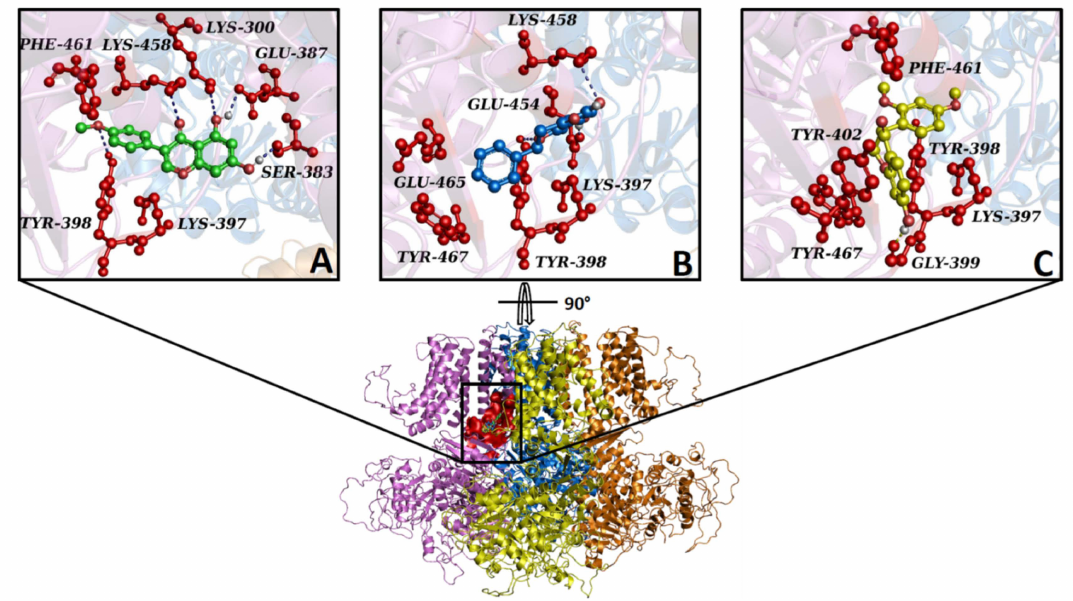
Figure 8. Overview of K Ca 1.1 channels docked with biochanin A, pinocembrin, and sativanone. The K Ca 1.1 channel’s 3D structure is depicted in a multicolour illustration, while the binding pocket is reported as a red surface. ( A – C ) Interaction network of ( A ) biochanin A, ( B ) pinocembrin, and ( C ) sativanone in complex with the K Ca 1.1 binding residues (red balls and sticks) after the docking simulation. The hydrogen bond is represented as a purple dotted line. For clarity, only polar hydrogens are